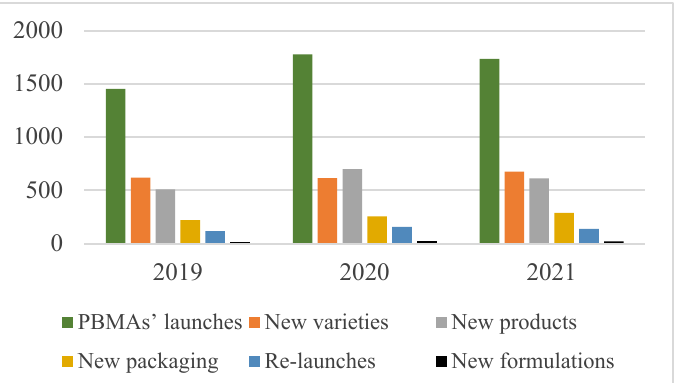
Figure 1. Number of PBMAs’ launches ( n = 4965—green bar), new varieties ( n = 1910—orange bar), new products ( n = 1822—gray bar), new packaging ( n = 1822—yellow bar), re-launches ( n = 386—blue bar), and new formulations ( n = 58—black bar) launched worldwide over the past three years (2019–2021). Abbreviations: PBMAs, plant-based meat alternatives.